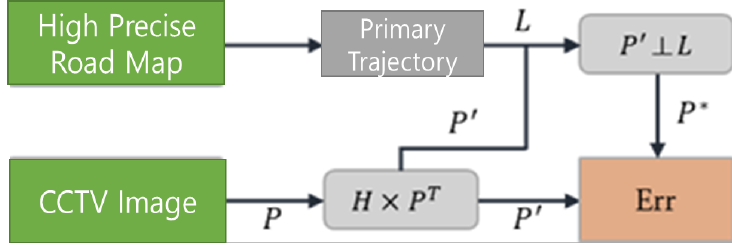
Figure 7. Process for error estimation in the global coordinate system.